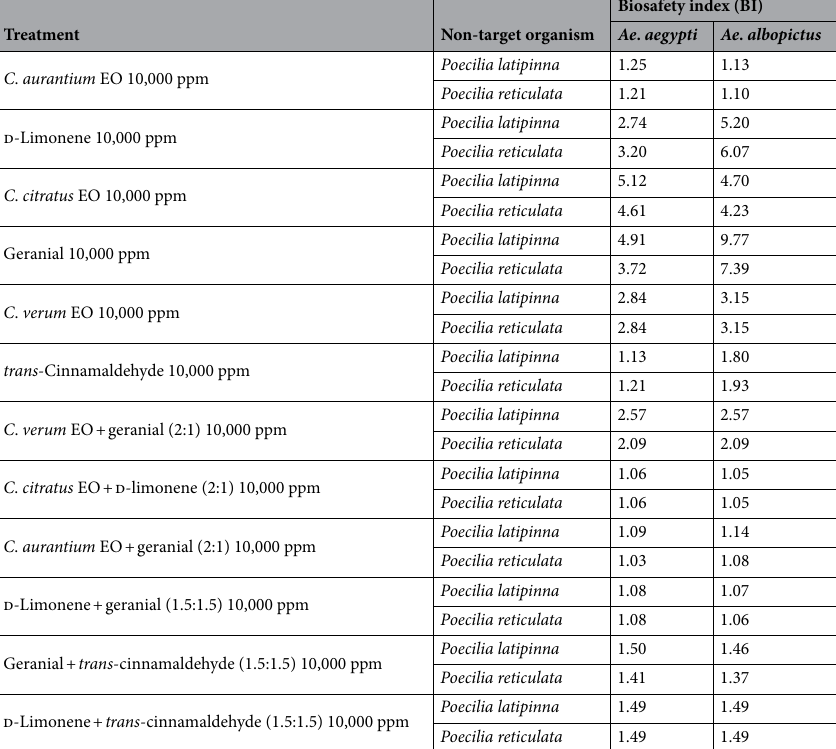
Table 5. Biosafety index (BI) against Poecilia latipinna and Poecilia reticulate sharing the same ecological niche of Aedes aegypti and Aedes albopictus , exposed to Cinnamomum verum , Citrus aurantium , and Cymbopogon citratus EOs and their major constituents and combined